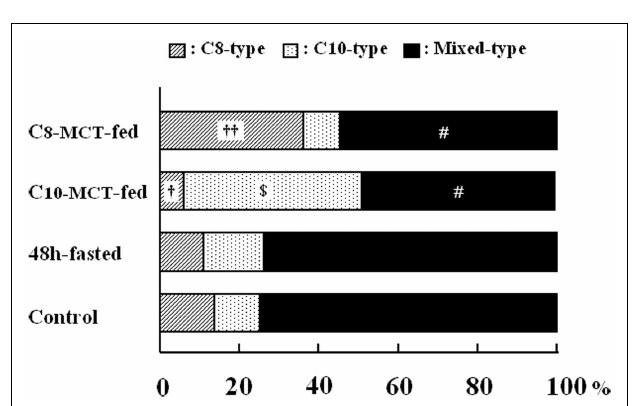
FIGURE 3 |The proportion of secretory granules that possessed immunoreactivity exclusively for C8-ghrelin (C8-type, cross-hatched column), or exclusively for C10-ghrelin (C10-type, dotted column), or for both C8- and C10-ghrelin (mixed-type, filled column) in ghrelin-producing cells of the stomach in control mice fed ad libitum a standard chow (Control), in mice fasted for 48h (fasted), or in mice after 2-weeks ingestion of glyceryl-tri-octanoate (C8-MCT-fed) or glyceryl-tri-decanoate (C10-MCT-fed) . Data were extracted and analyzed from approximately 250 secretory granules of ghrelin-producing cells in each group ( n = 5 mice in each group). † p < 0.01; †† p < 0.001 vs. control and fasted. p < 0.001 vs. control, C8-MCT-fed, and fasted. # p < 0.001 vs. control and fasted.